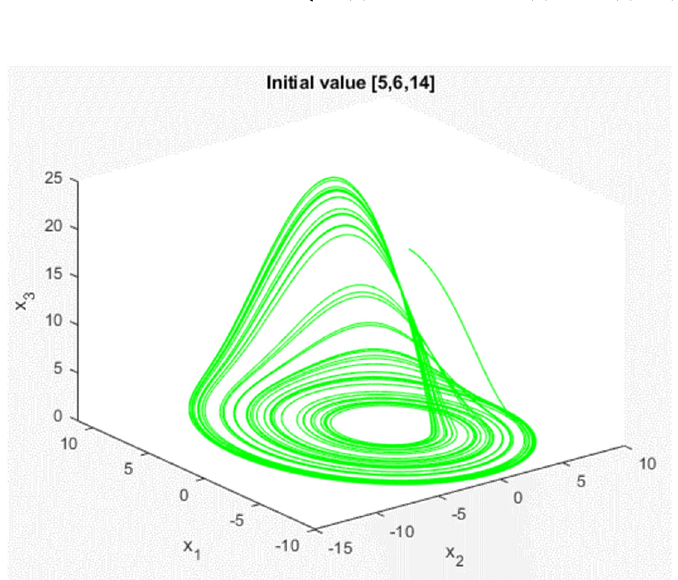
Figure 6. Response of Rössler chaotic system.